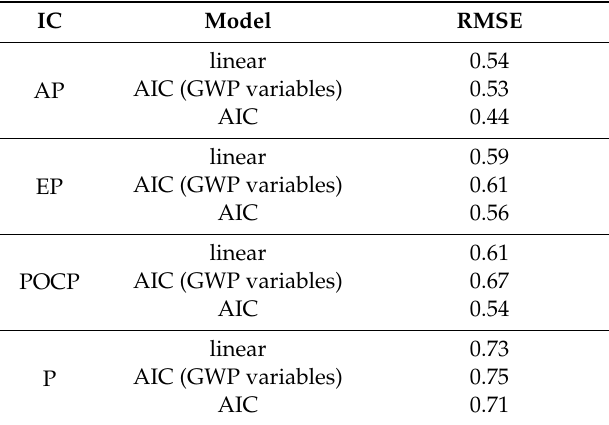
Table 25. Comparison of RMSE between the two models.